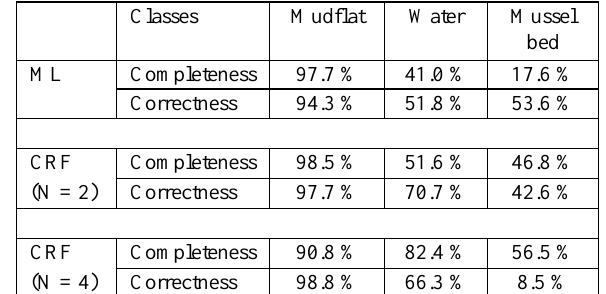
Table 1: Classification results with rates for Completeness and Correctness for the Maximum Likelihood (ML) Classification and the CRF method for varying neighbourhood N